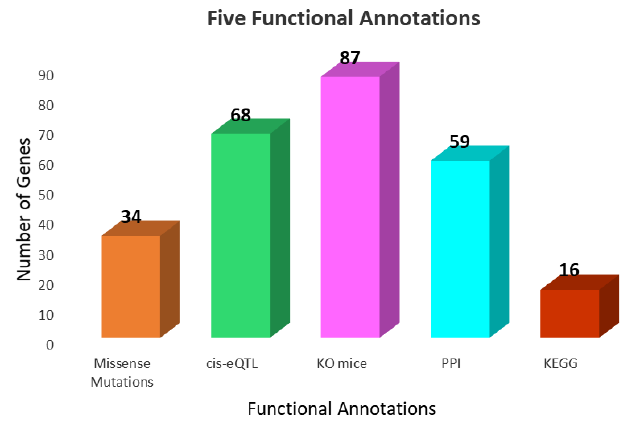
Figure 2. Histogram distribution of functional annotations. Score on each of Functional Annotations